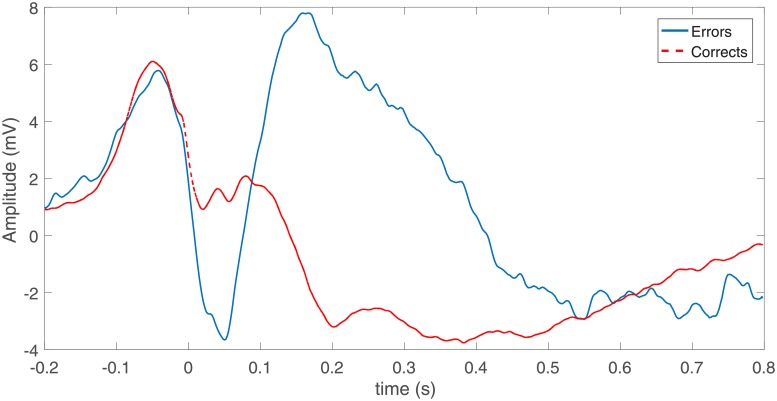
Average error and correct responses at FCz electrode across all trials and all subjects.